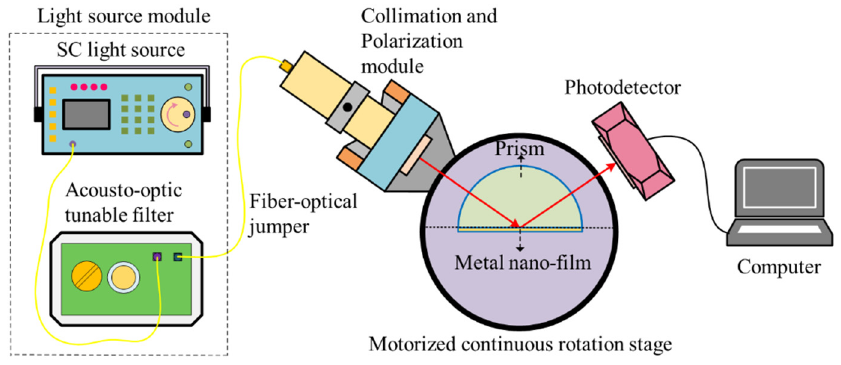
Figure 3. The experimental setup of the angle modulated surface plasmon resonance (SPR) system.